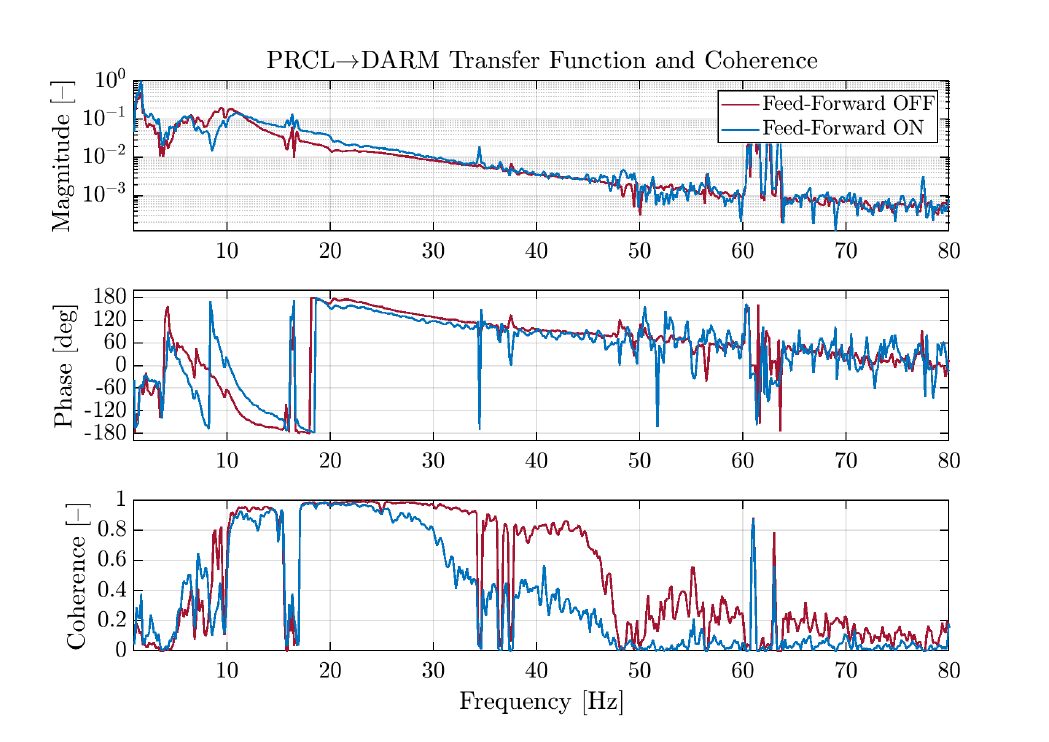
Figure 3. PRCL to SSFS Feed-Forward, from top to bottom: transfer function and coherence between PRCL and